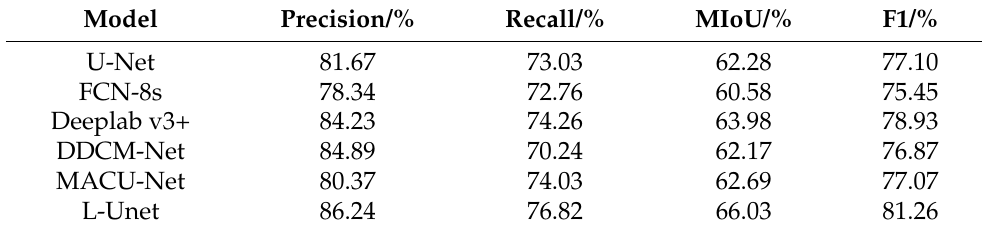
Table 3. Comparison of the performance of different models on a new